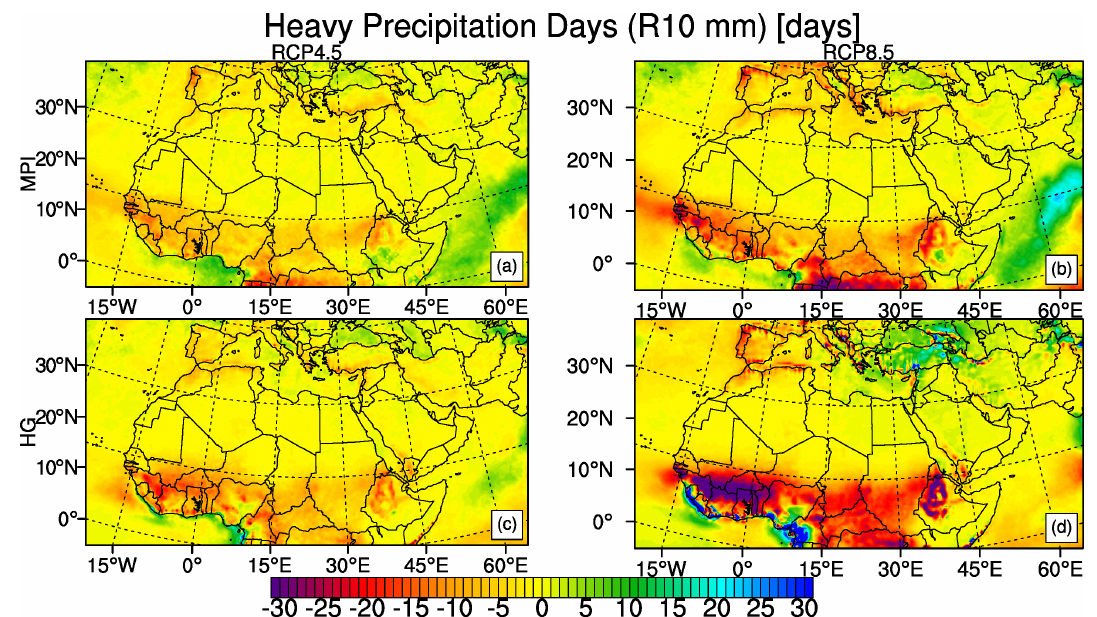
Figure 13. The temporally averaged changes in R10mm for the period of 2071–2100 displayed as differences (in days) with respect to the reference period 1971–2000 for the model MPI-ESM-MR with RCP4.5 ( a ) and RCP8.5 ( b ) and for the model HadGEM2-ES with RCP4.5 ( c ) and RCP8.5 ( d